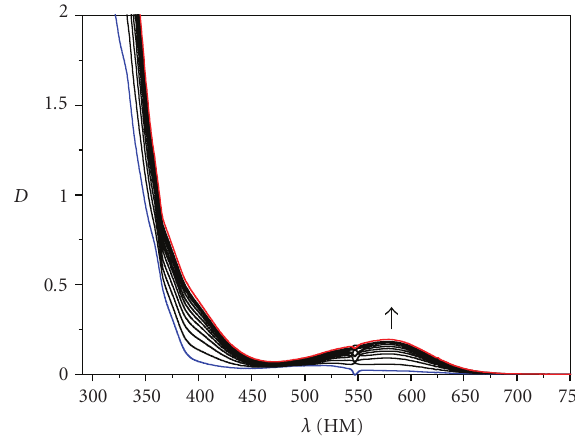
Figure 6: Absorption spectra of the spiropyran 7 in the oligo-